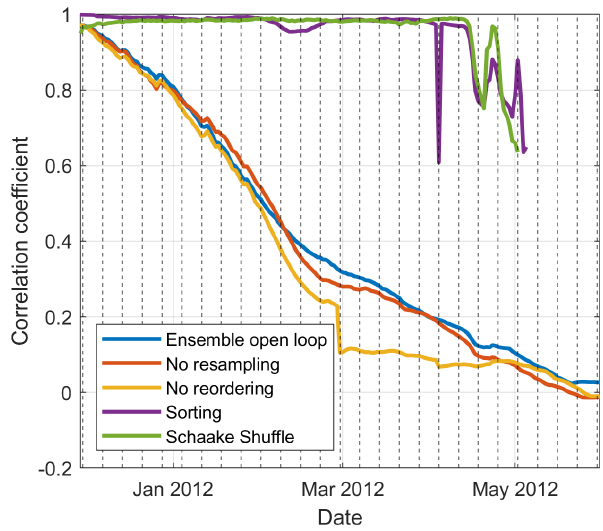
Figure 7. Evolution of the correlation between between two adja- cent grid cells over the winter of